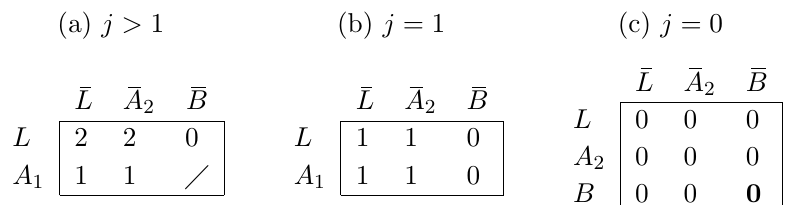
Table 1 . Number of independent coe(cid:14)cients of the superspace correlator as di(cid:11)erent shortening C k conditions are chosen. The slash means that there is no consistent three-point function. The boldface zero means that the three-point function is identically zero. Other zeros imply that the three-point function is completely (cid:12)xed in terms of q , (cid:22) q and j . In all cases these numbers refer to real degrees of freedom as the are either all real or all purely C k